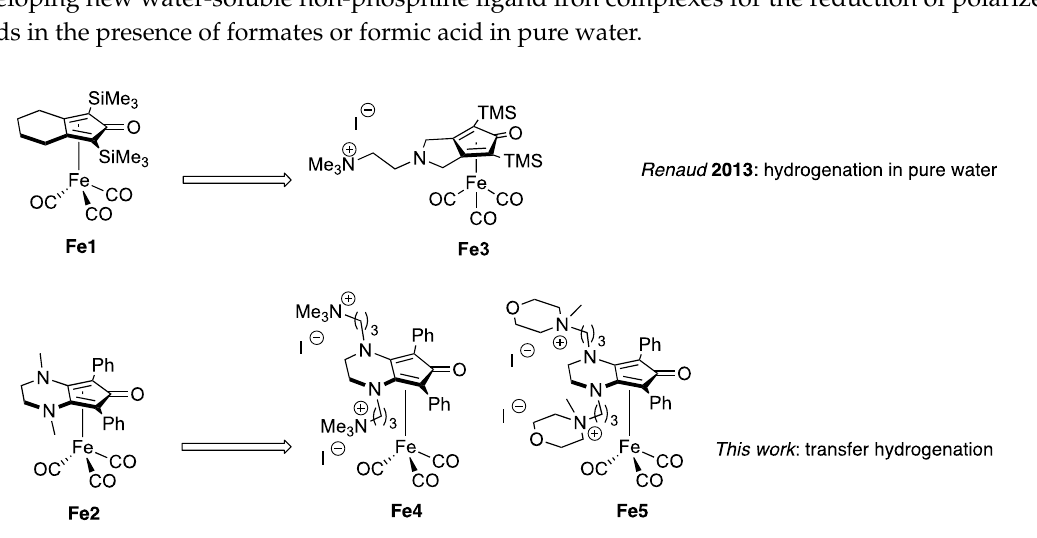
Figure 1. Previous water-soluble cyclopentadienone iron complex and new complexes for application reduction.